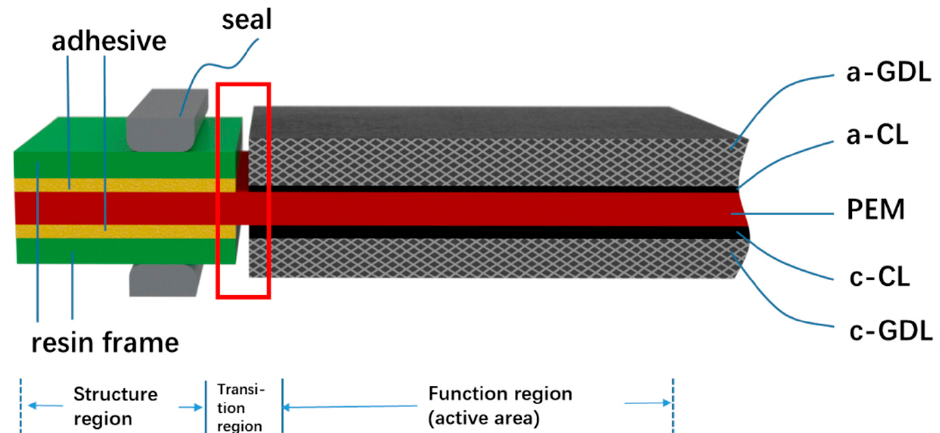
Figure 1. Schematic diagram of the primary structure of an MEA.